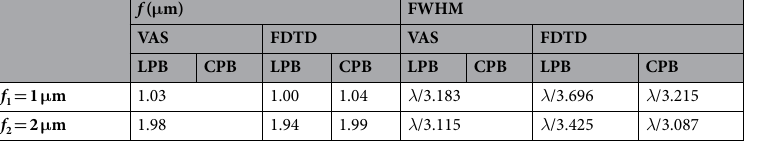
Table 2. Comparison of the designed and simulated results of the focal length f and FWHM for LPB and CPB.